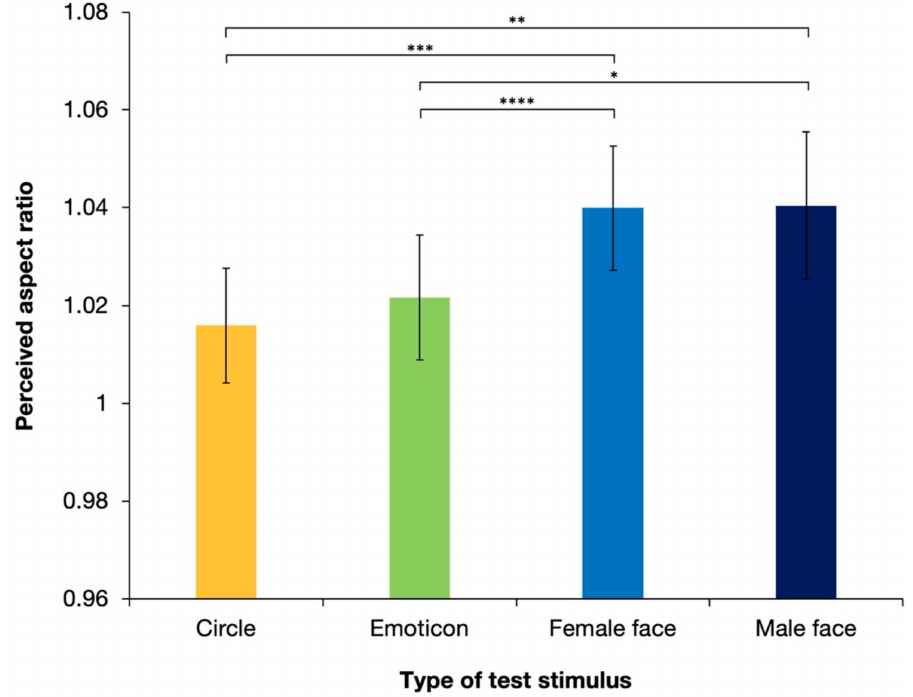
Figure 4. Results of the mean perceived aspect ratios of response circles averaged over 17 observers in Experiment 1. Error bars denote standard errors of the mean. The shape-contrast effect was strengthened significantly by a human face stimulus. Asterisks indicate significant differences resulting from multiple comparison test for the main effect of stimulus type; * p < 0.05, ** p < 0.01, *** p < 0.005, **** p <